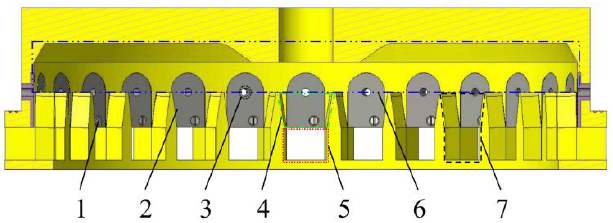
Figure 2. Top view of seeding plate: (1) fastening screw, (2) suction-hole replacement plate (3) suction hole, (4) filling hole, (5) collection hole, (6) annular groove, and (7) type hole.